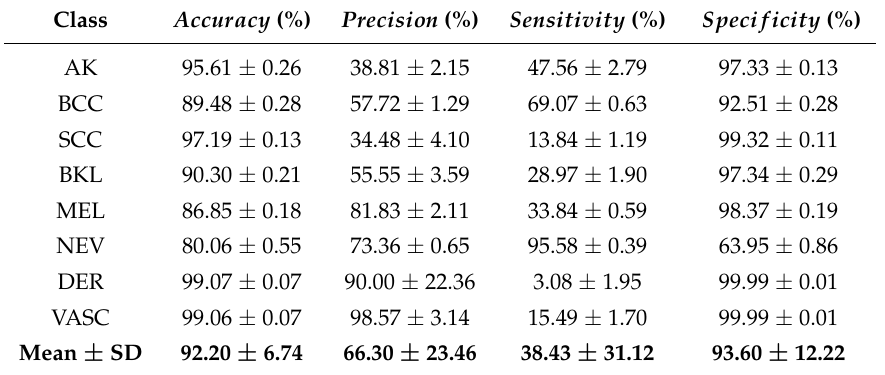
Table 7. Mean ± SD of five performance metrics for the test dataset of the Exp-3 with α = 0.4. The test dataset has 7599 images.